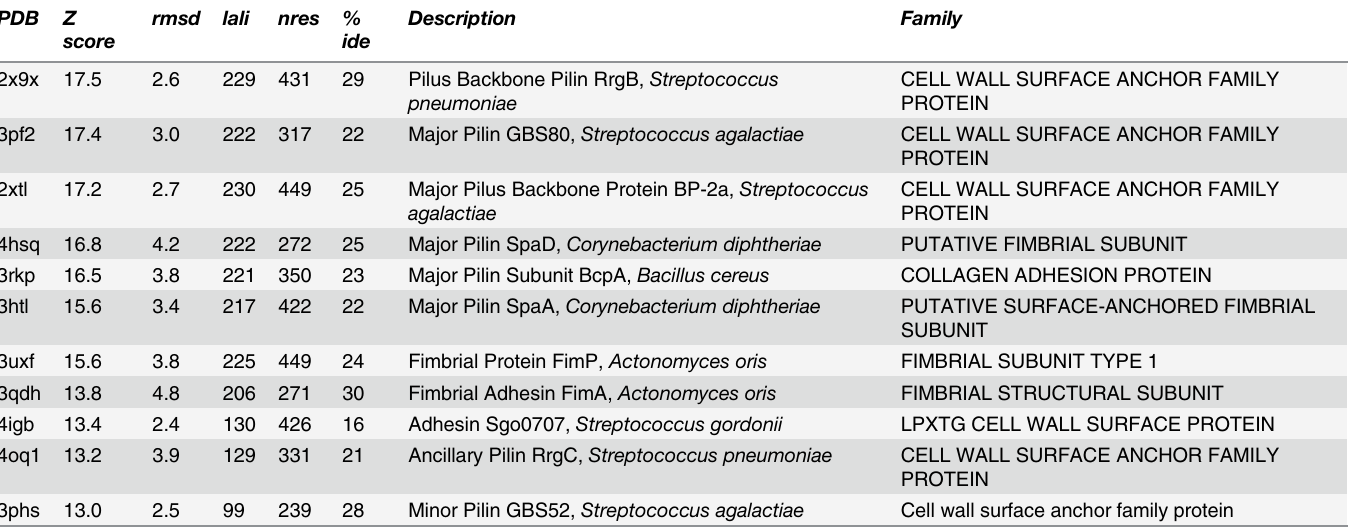
Hits are ranked by Z-Score with best hits at the top of the table. PDB : Protein Data Bank rmsd : root-mean-square deviation of C α atoms of superimposed proteins in Angstroms lali : number of structurally equivalent positions nres : number of structurally equivalent aligned residues %ide : percentage of amino acid identity in aligned positions